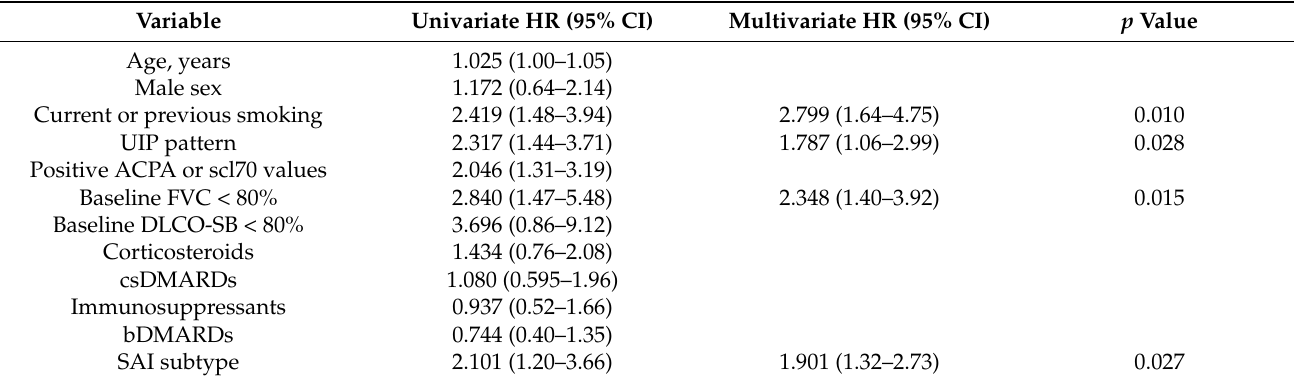
Table 4. Cox regression model (adjusted for progression of